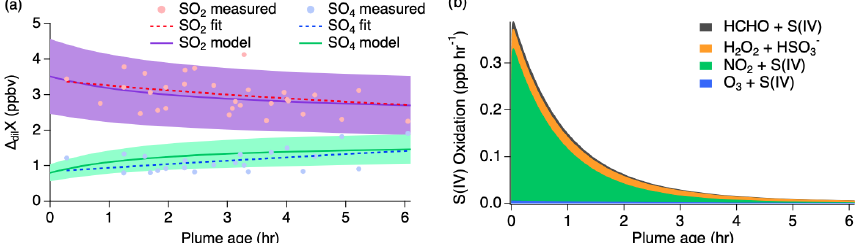
Figure 7. (a) Dilution-corrected ( (cid:49) dil X) measurements of 3 August 2019 shown by the markers and measurement fits shown by the dashed lines compared to the SO 2 and sulfate model results represented by the solid lines, with shading denoting an estimated 30% model uncer- tainty. The sulfate (SO 4 ) measurements represent total sulfate which potentially includes organosulfur. (b) Stacked modeled S(IV) oxidation rates leading to sulfate and HMS